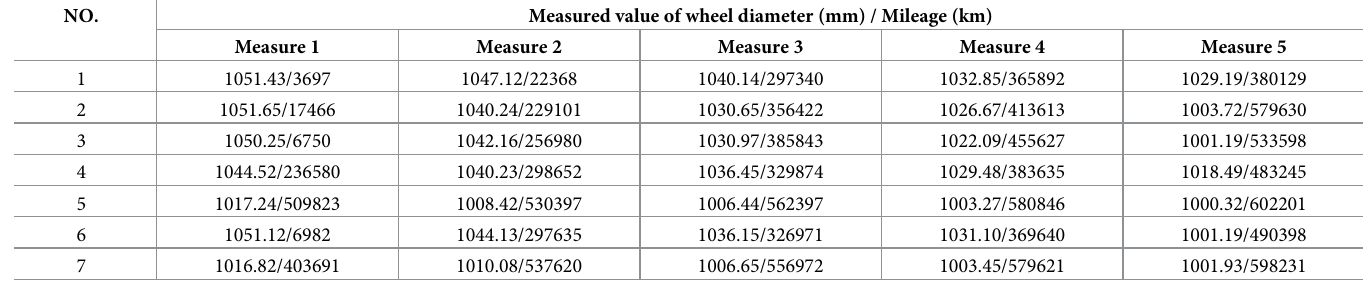
Table 1. DF11 locomotive wheel diameter measurement report (five